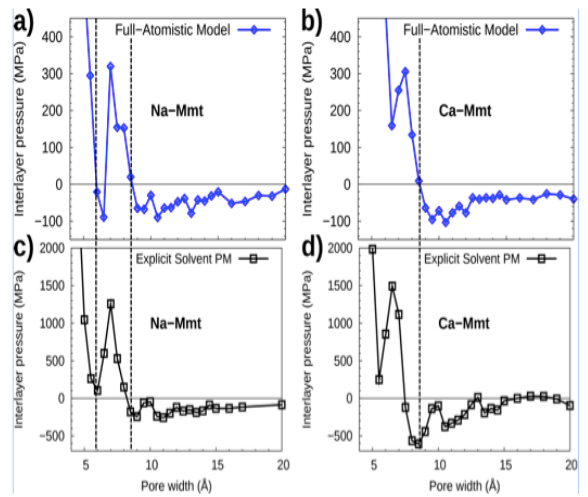
Figure 5: Interlayer pressure versus pore width for (a and b) Na-Montmorillonite and for (c and d) Ca-Montmorillonite computed with (a and c) the full-atomistic model or with (b and d) the Explicit Solvent Primitive Model.